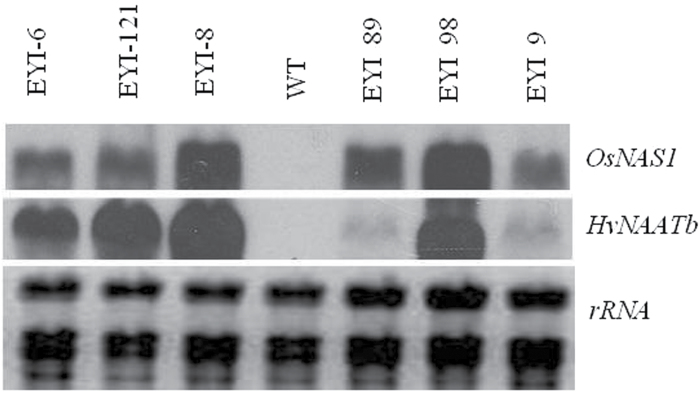
Representative RNA blot analysis showing transgene expression in the leaf tissue of wild-type (WT) and six representative independent T2 transgenic lines. HvNAATb, barley nicotianamine aminotransferase; OsNAS1, rice nicotianamine synthase; rRNA, ribosomal RNA. Wild-type and transgenic lines were grown under nutrient-sufficient conditions, and total RNA was isolated from flag leaves at physiological maturity.